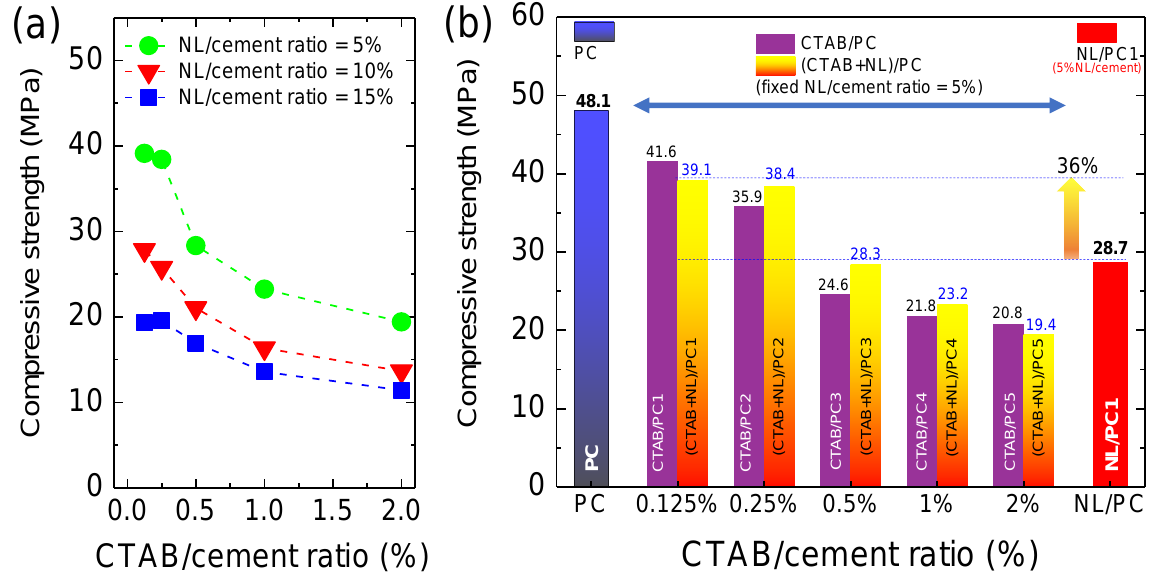
Figure 7. ( a ) CTAB/cement ratio dependence of the compressive strength for the (CTAB + NL)/PC composites with NL/cement ratio = 5%, 10%, and 15%. ( b ) Compressive strength of the CTAB/PC and (CTAB + NL)/PC (fixed NL/cement ratio = 5%) composites with different CTAB/cement ratios (0.125 – 2%) compared to those of the control PC and NL/PC1 composite.